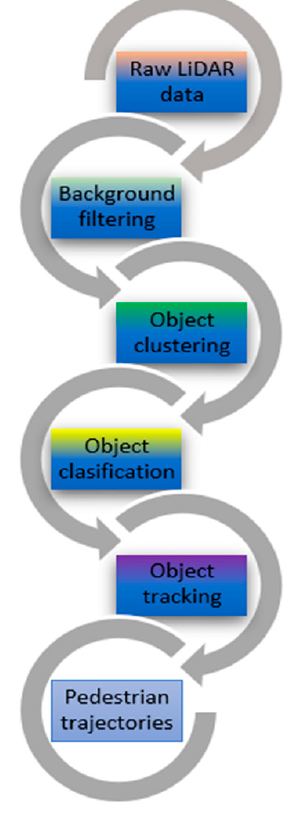
Figure 6. Flow chart of data preprocessing.